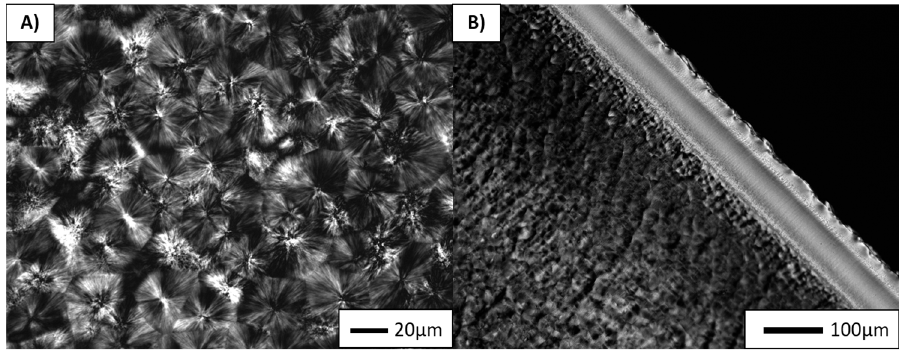
Figure 2. POM micrographs of neat PP sample in transferred direction to the injection flow. Table 2. Average diameter of PP spherulites and PET fibrils in the composites. Table 2. Average diameter of PP spherulites and PET fibrils in the composites.